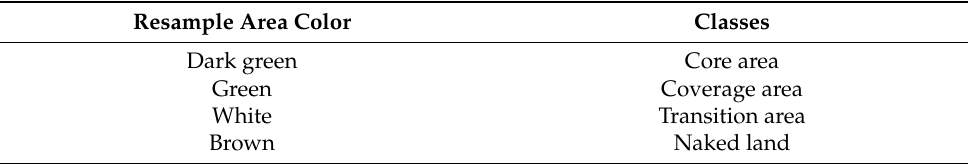
Table 4. Block color and category correspondence.